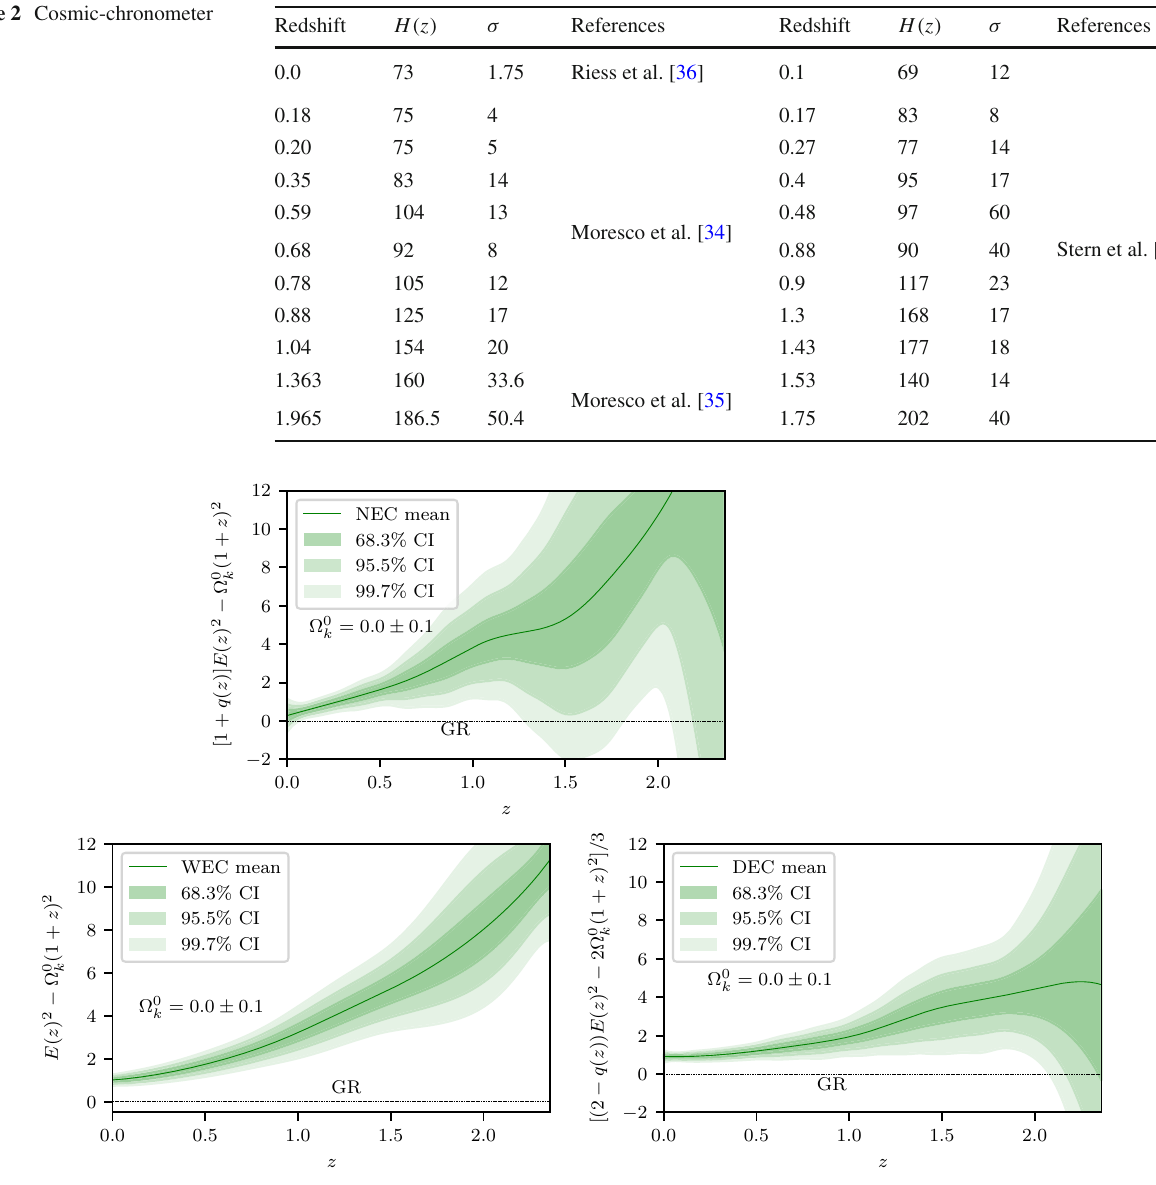
Fig. 1 The green solid lines are the mean estimates of the NEC (upper panel), WEC (left-lower panel) and DEC (right-lower panel). The green shaded areas are their 68.3%, 95.5% and 99.7% CIs at different redshift values obtained from the reconstructed q ( z ) by using SNe Ia + BAO +